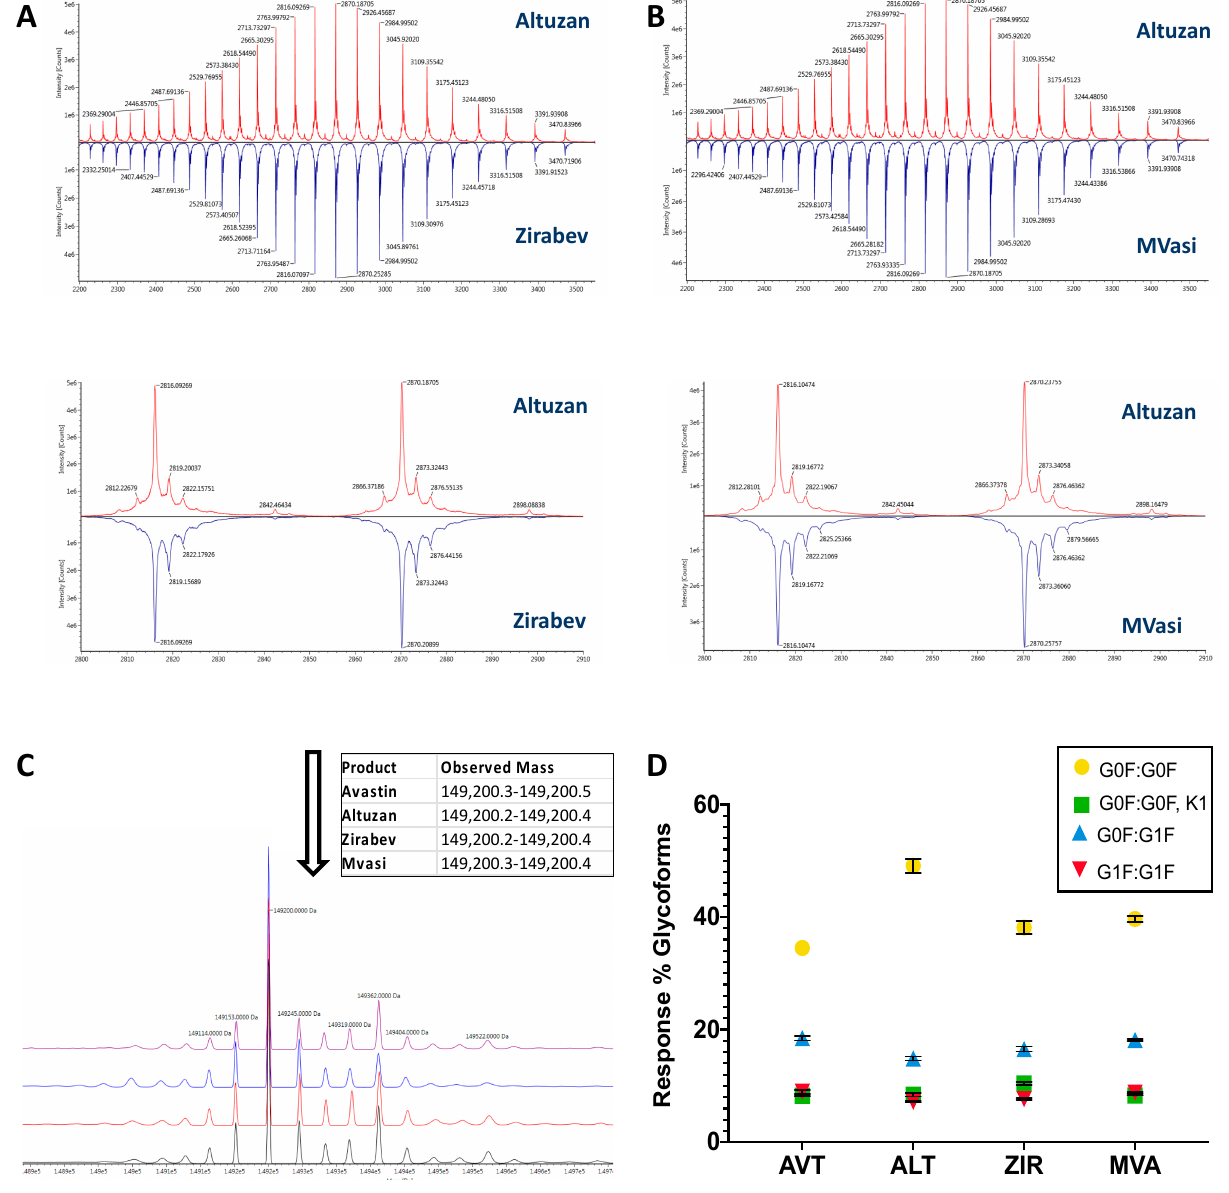
Figure 2. Comparative raw MS spectrums of Zirabev ( A ) and Mvasi ( B ) in zoom-out(up) and zoom- in(down) form. ( C ) Overlay representation of deconvoluted MS spectrums of samples and the list of observed molecular mass of the main peaks. ( D ) Graph of percentages of major glycoforms identified in the samples. Each sample was injected three times.